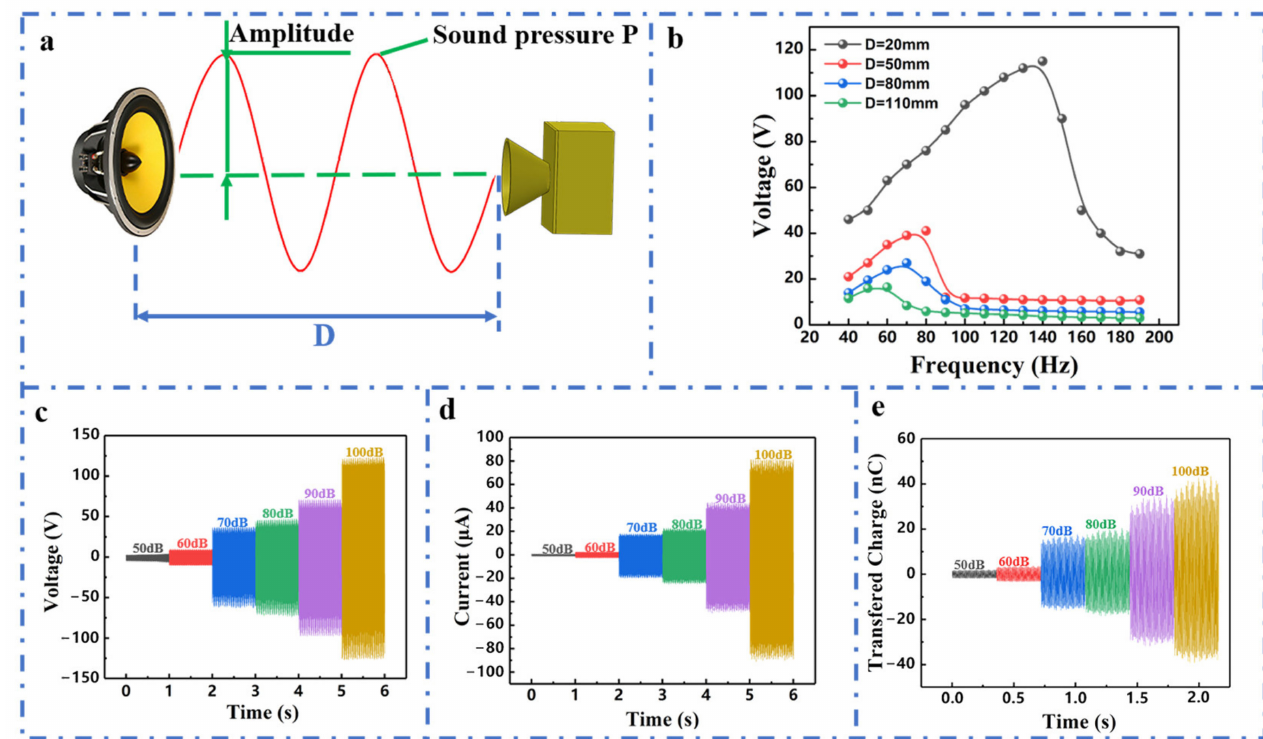
Figure 3. Electrical output performance of the CHR-TENG under different sound energy conditions. ( a ) Schematic diagram of acoustic wave propagation and capture. ( b ) Open-circuit voltage output of the CHR-TENG under the excitation of acoustic waves with different frequencies in distances ranging from 20 to 110 mm. ( c ) Open-circuit voltage, ( d ) short-circuit current and ( e ) transferred charge output of the CHR-TENG under acoustic excitation with pressure levels varying from 50 to 100